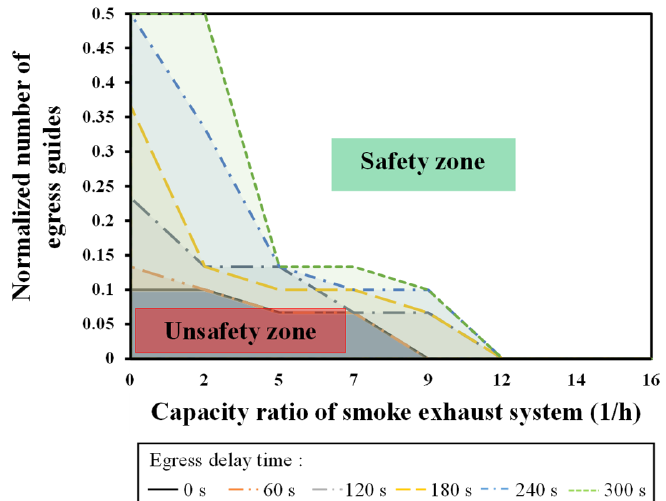
Figure 9. Egress safety criteria for nursing hospitals considering smoke exhaust